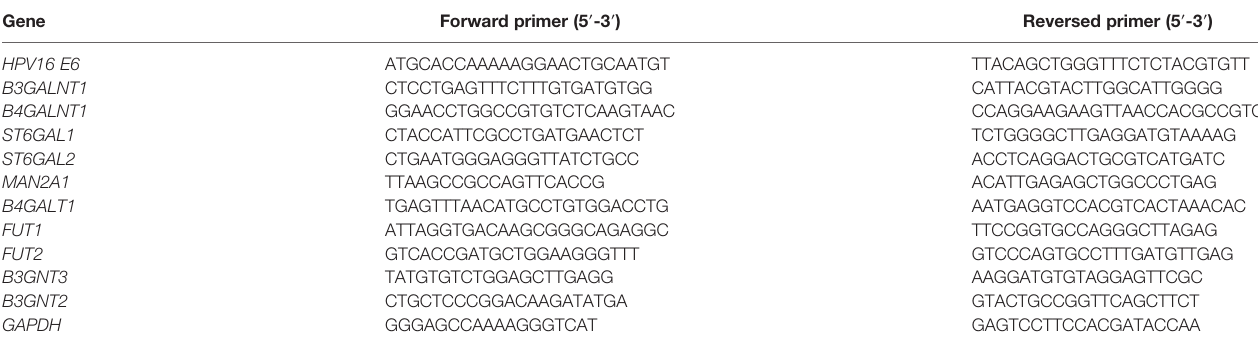
TABLE 1 | Primer sequences for genes. Gene Forward primer (5 ′ -3 ′ ) Reversed primer (5 ′ -3 ′ )